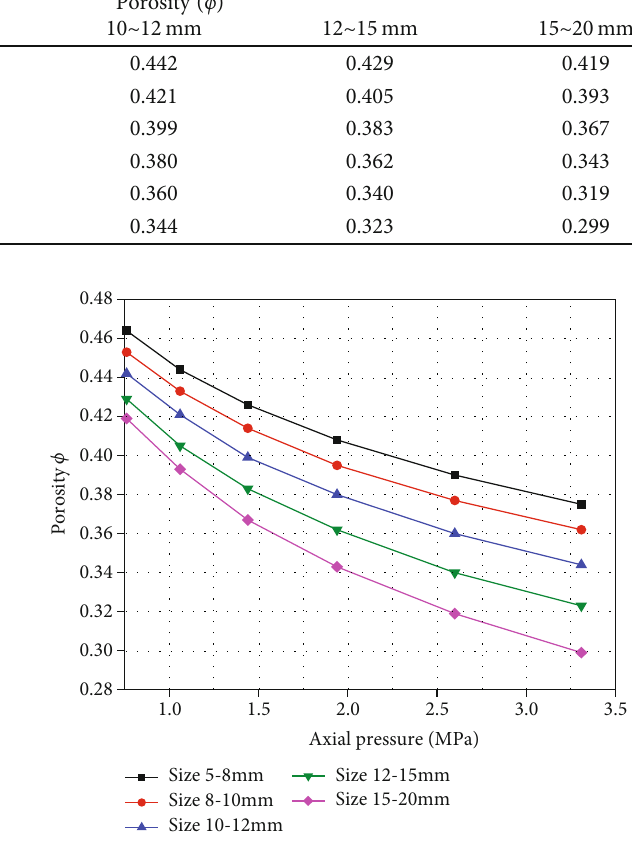
Figure 7: The variation of porosity with load for di ff erent broken rock samples.